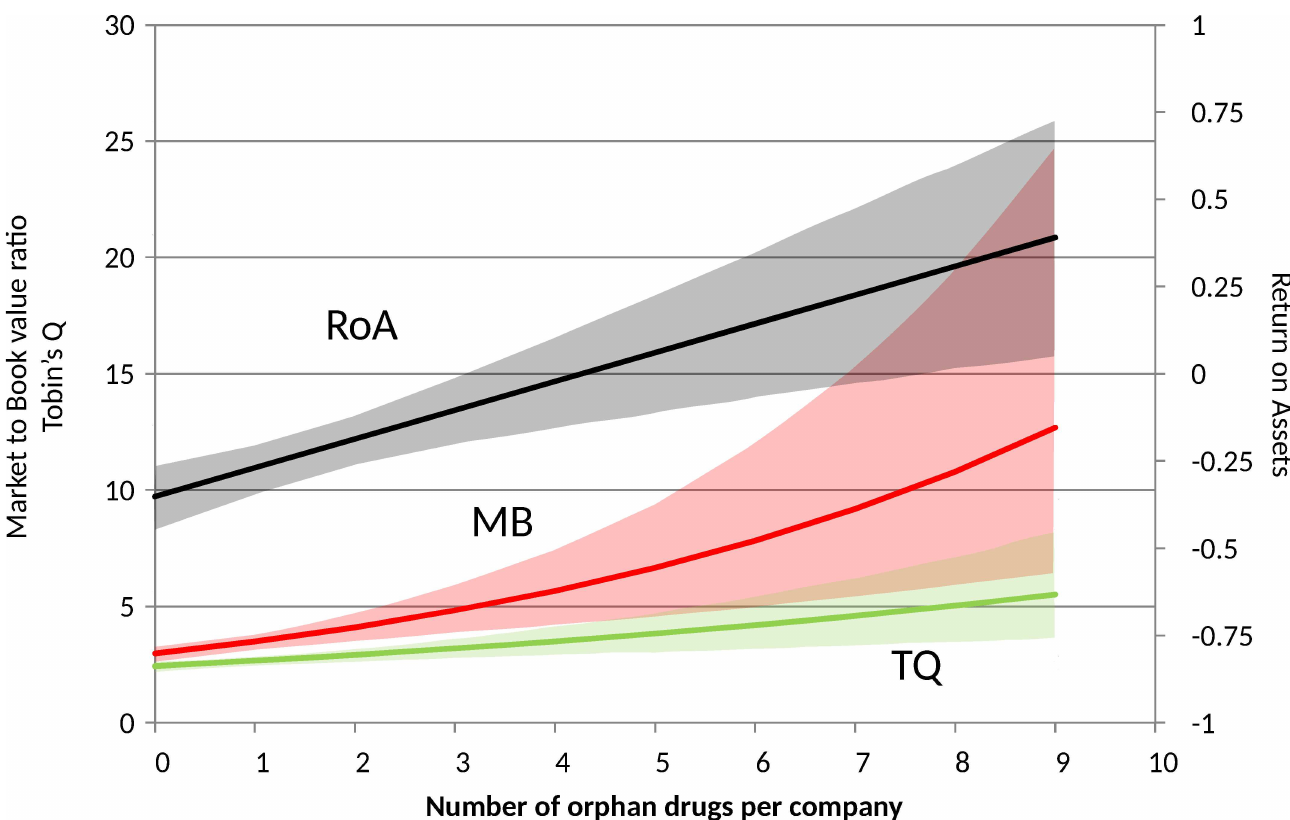
Fig 1. Relation between the number of orphan drugs marketed and the performance of companies. Calculated from predictionsof the fitted pooledOLS regression,with NORPHAN as the explanatoryvariable of interest, and with all other covariates fixed to averagevalues. Data are presented as the means and 95% confidence bounds (S4